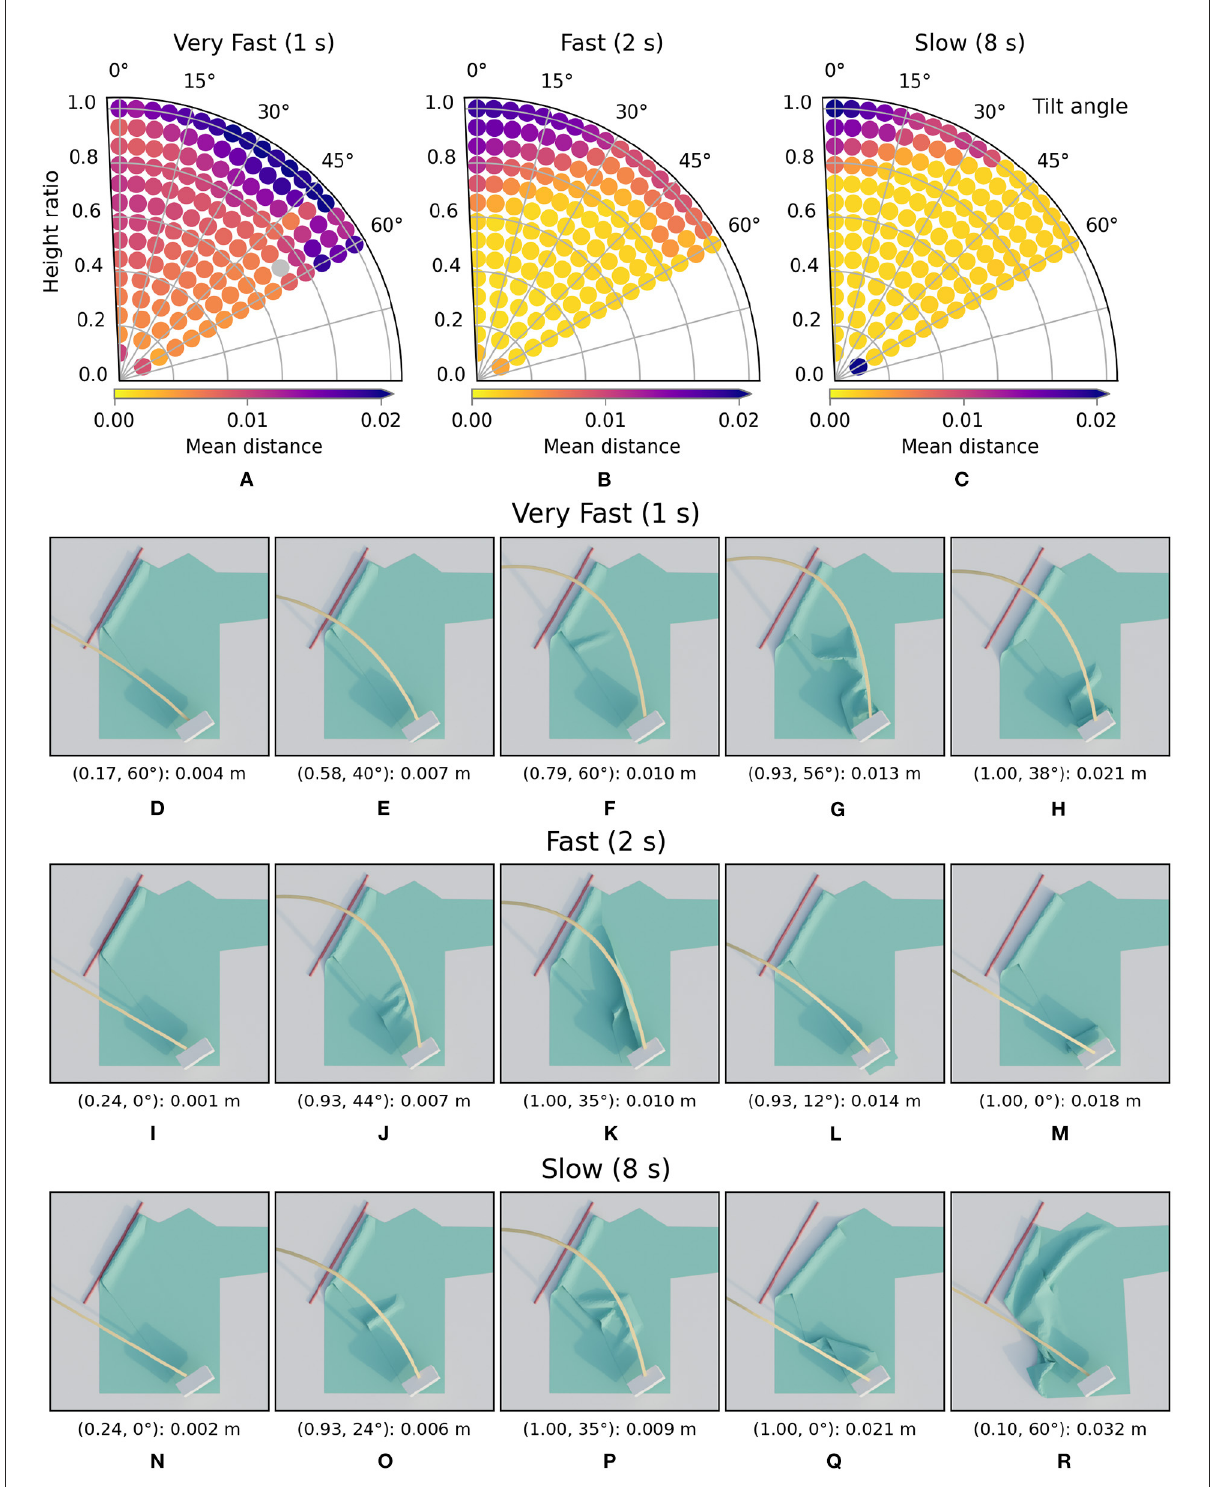
FIGURE15 The first row shows the trajectory performances (A–C) for the velocity variations respectively 1, 2, and 8 s. Below (D–R) are the images of simulated results for the velocity variations. For each row, the images are ordered from best (left) to worst (right) result. The annotation below each image is in the following format: (height ratio, tilt angle): mean